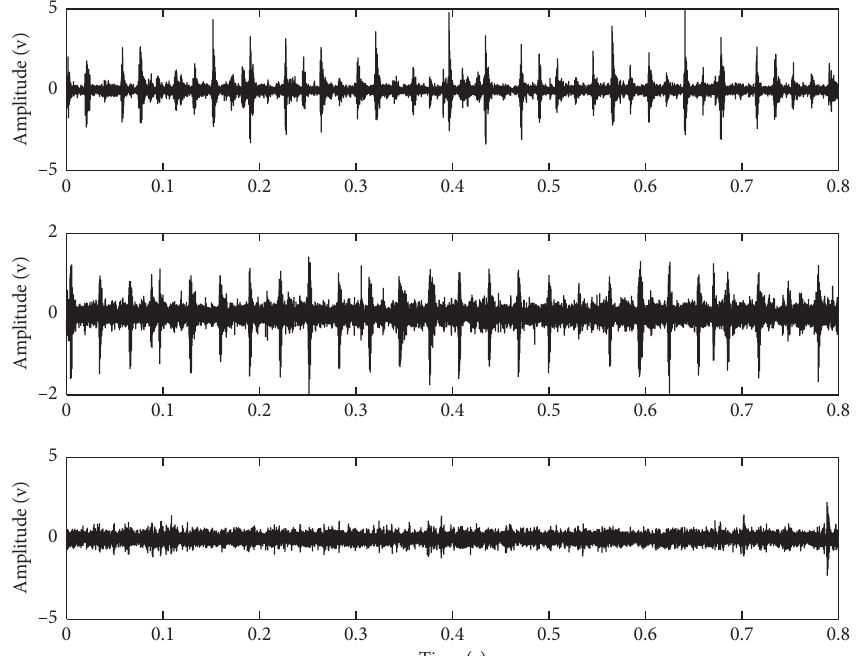
Figure 6: Time-domain waveforms of test bearing’s three states (inner race, outer race, and normal state) [ S ′ ].